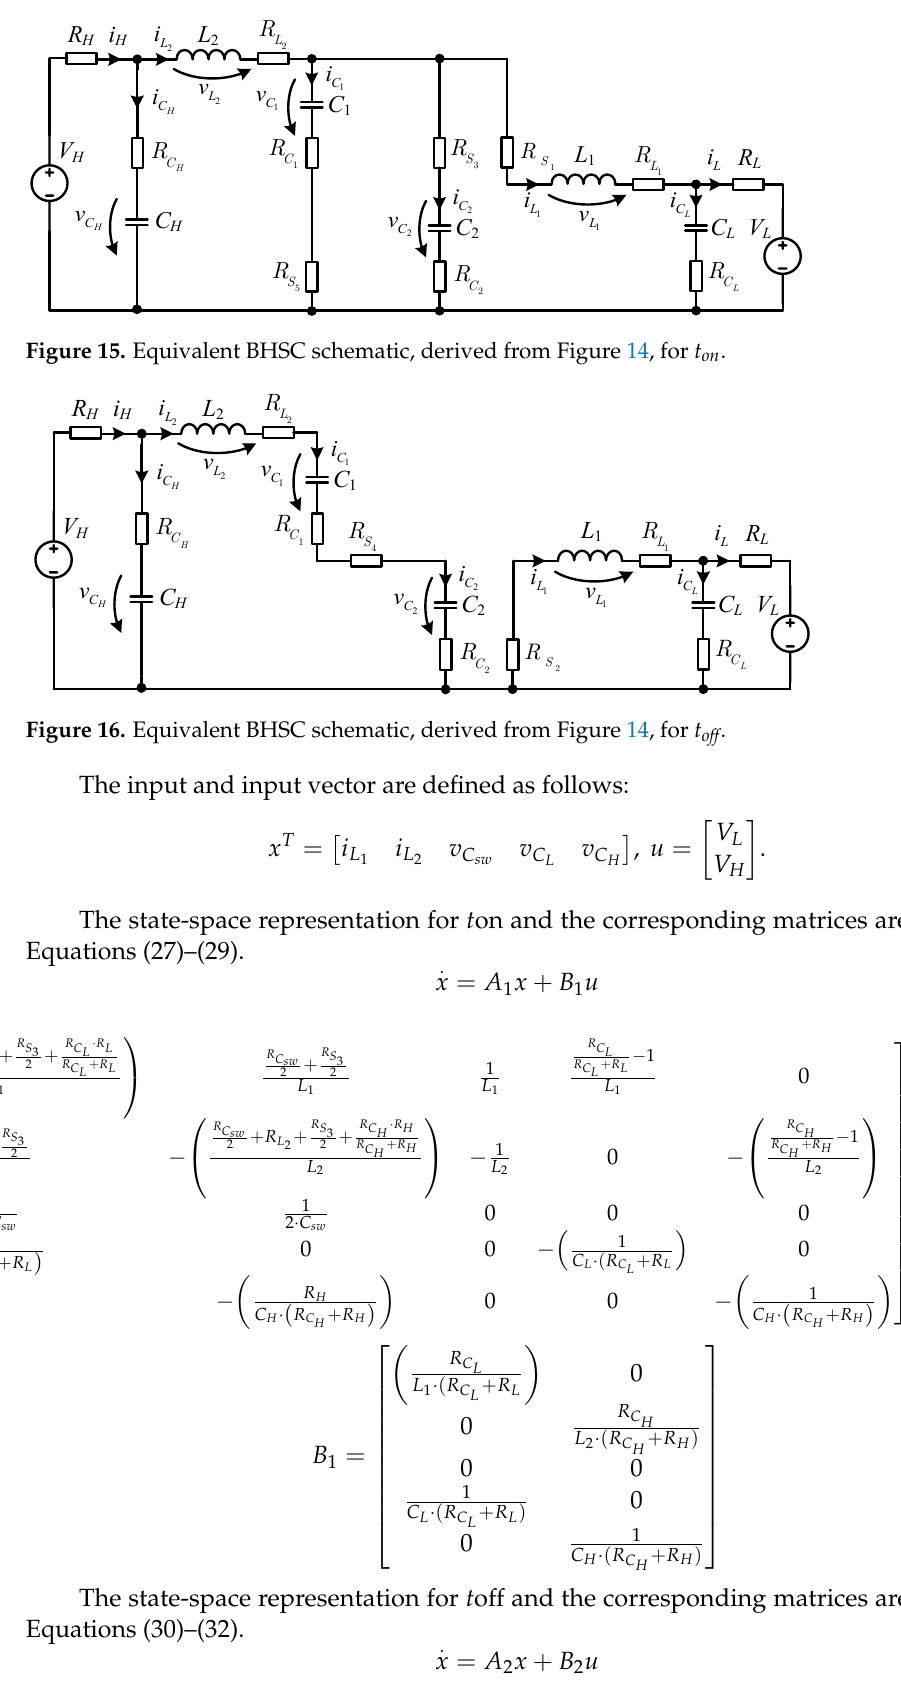
Figure 14. BHSC schematic with parasitic components, used for stability analysis.